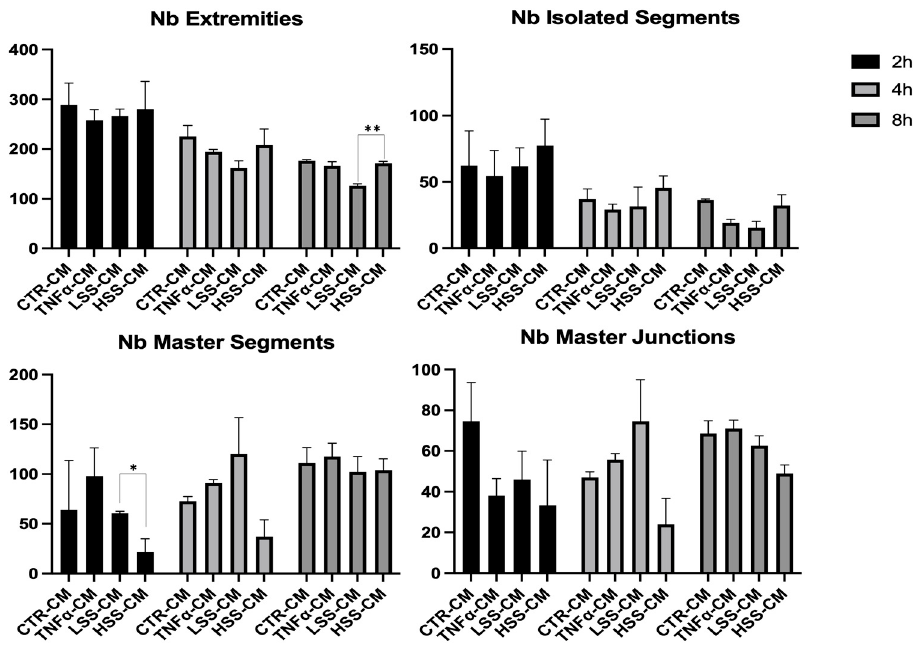
Figure 12. Angiogenesis analysis of tube formation assay at different time points. (* p < 0.05, ** p <